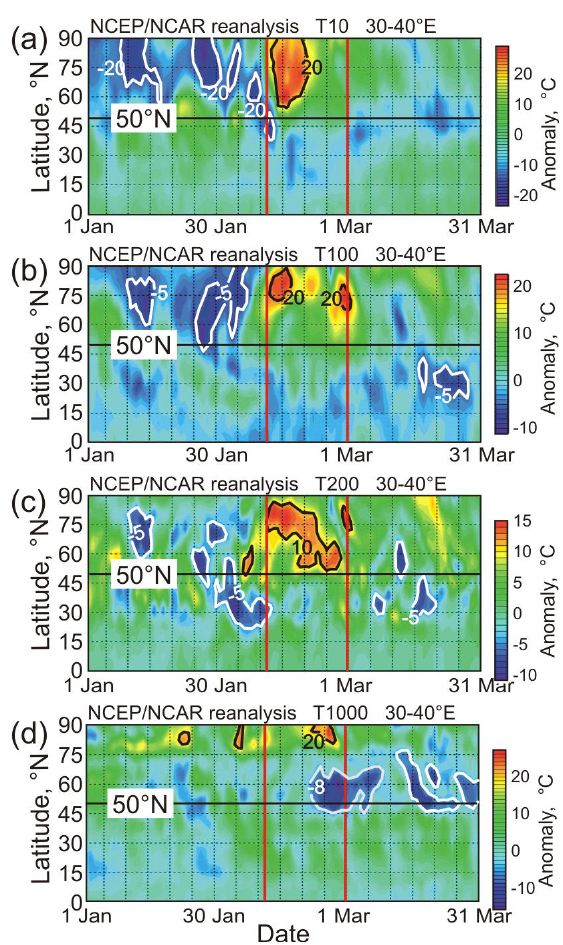
Figure 1. Time – latitude air temperature anomaly plots at the pressure levels 10, 100, 200 and 1000 hPa (T10, T100, T200 and T1000, respectively) during SSW event. Latitude 50ºN is marked by black solid line. Climatology 1981 – 2010 is used for the NCEP – NCAR reanalysis anomalies. This cold temperature anomaly period is also confirmed by altitudinal distributions in Fig.